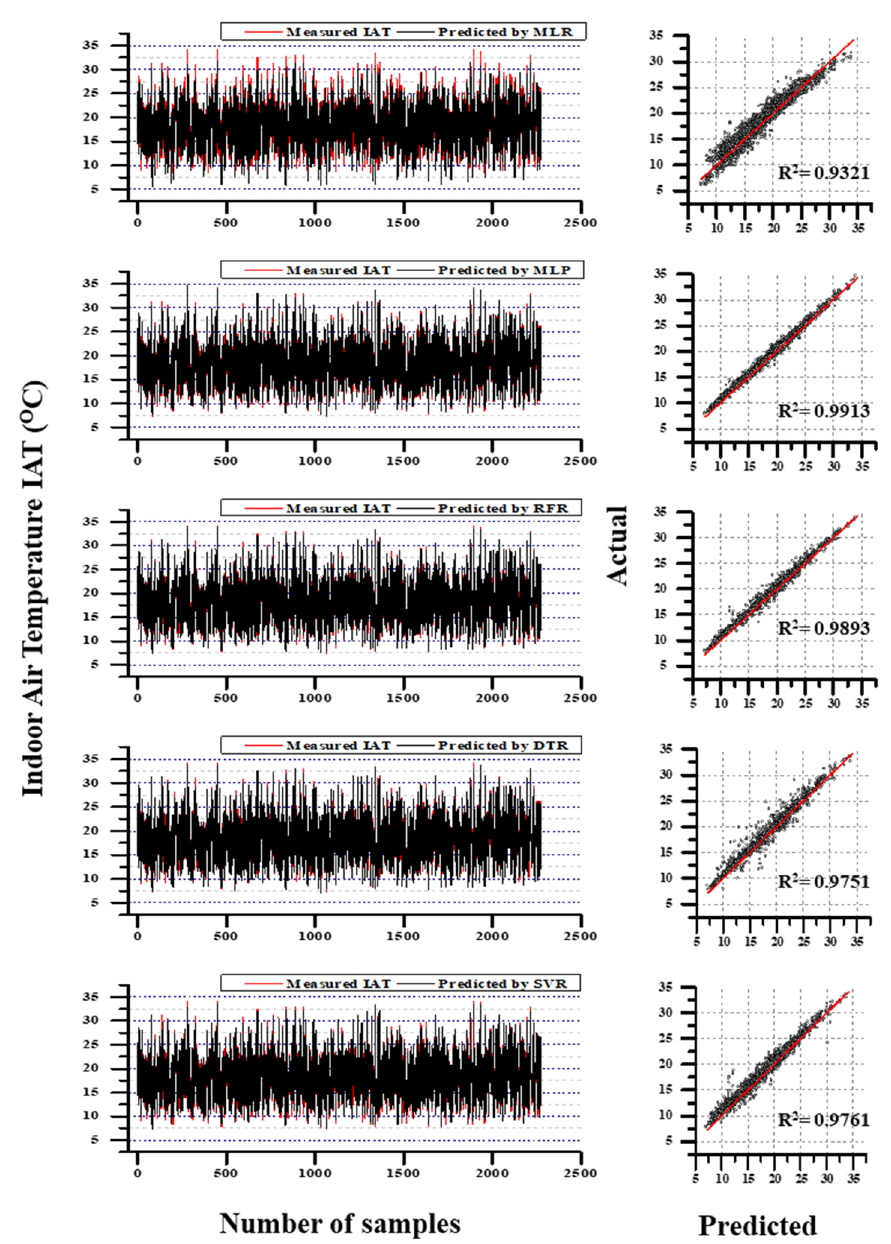
Figure 8. The comparison results between actual and simulated by MLR, MLP, RFR, DTR, and SVR with S3 for IAT prediction; the coefficient of determination between actual and predicted for all the models.